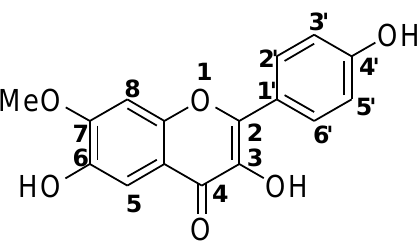
Figure 2. Structure of the flavonol.